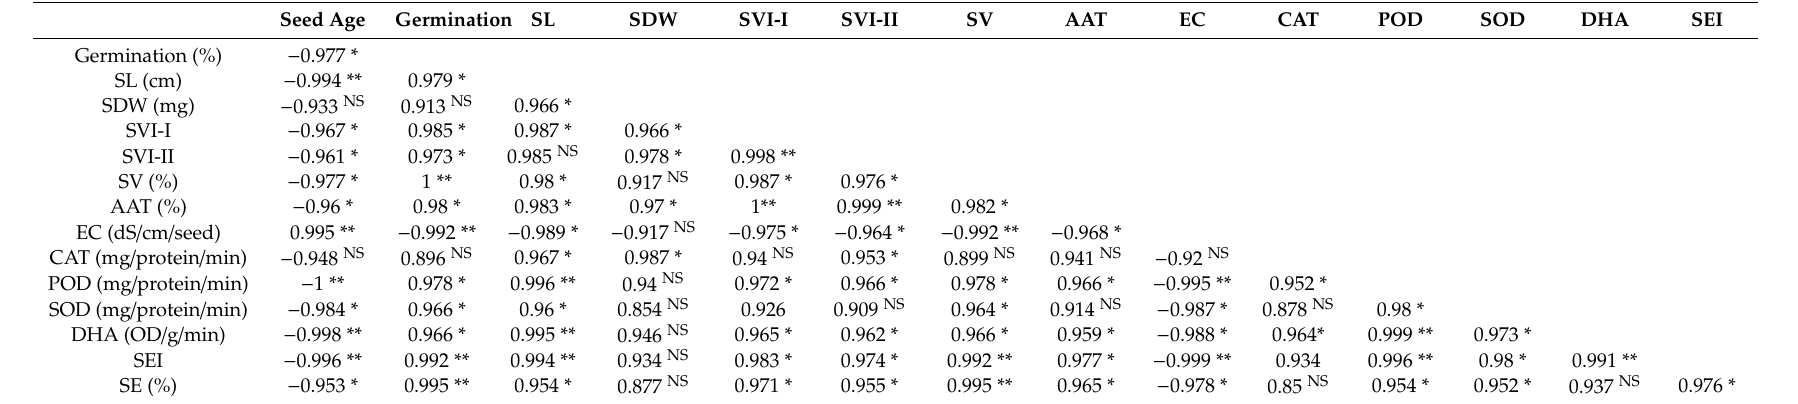
Table 1. Correlation matrix between age, physiological, biochemical and field parameters of onion